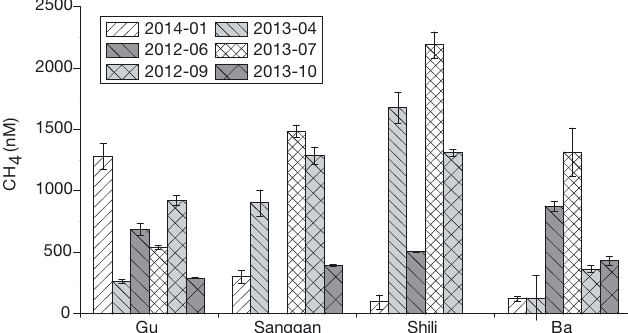
Fig. 4. CH 4 concentrations (mean ± SD) in different rivers flowing into Sanggou Bay in different seasons and years